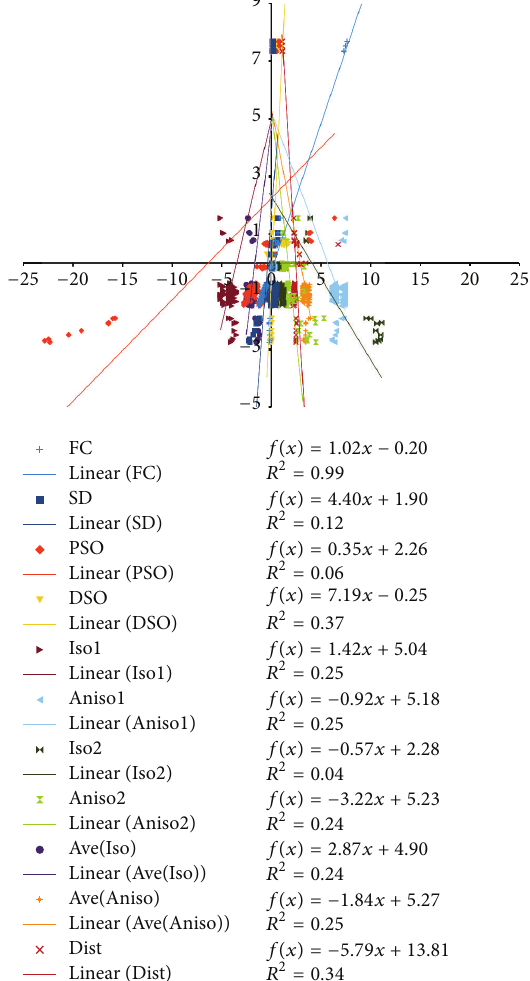
Figure 5: The linear equation and the correlation ( 𝑅 2 ) of J-coupling of selected atoms with their Ramsey terms, isotropic, anisotropic, average isotropic, and anisotropic shielding tensor of the two atoms involve spin-spin coupling. The suffixes 1 and 2 of the Iso and Aniso indicate first and second atom that are involved in the coupling. The J-coupling and FC were scaled with 0.1; Iso1, Aniso1, Ave(Iso), and Ave(Aniso) were scaled by 0.001 while Iso2 and Aniso2 were scaled by 0.01 in the